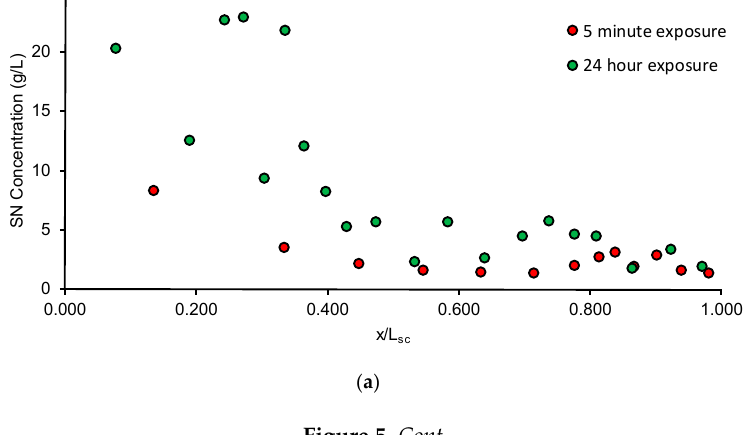
( a ) Figure 5. Cont. Figure 5.